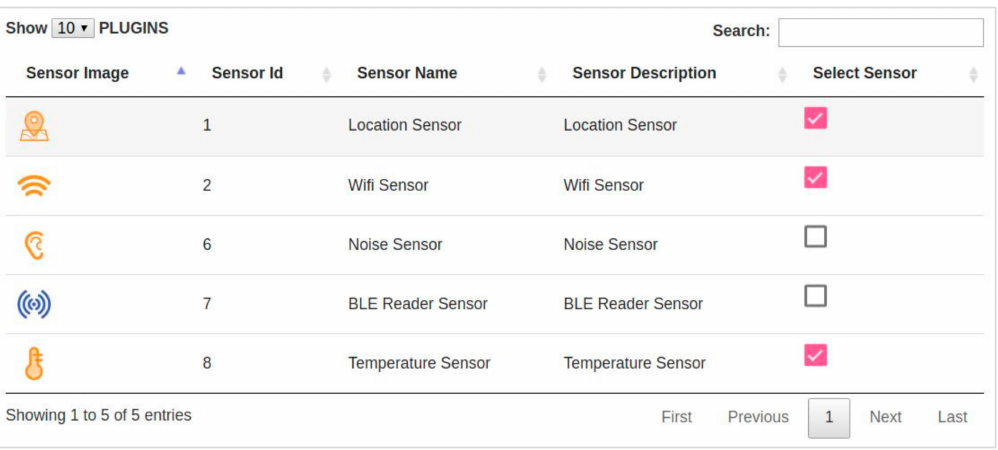
Figure 3. Screenshot of the Experimenter Portal to exemplify the definition of the spatiotemporal experiment constraints.